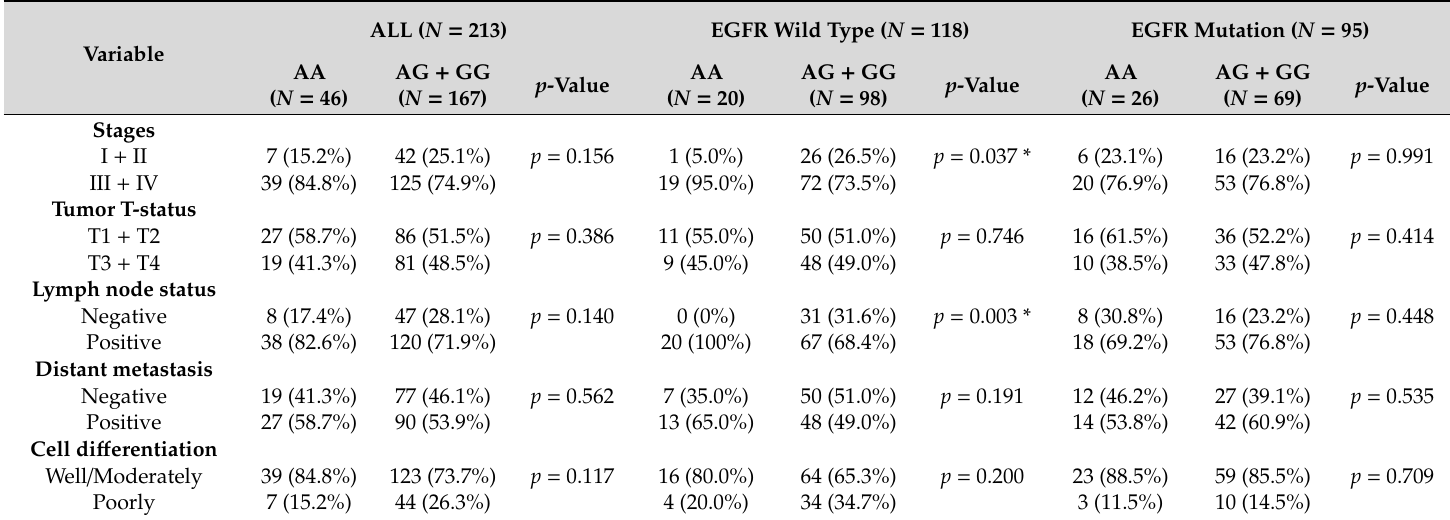
Table 5. Clinicopathologic characteristics of 213 male lung adenocarcinoma patients with epidermal growth factor receptor mutation, stratified by polymorphic genotypes of carbonic anhydrase 9